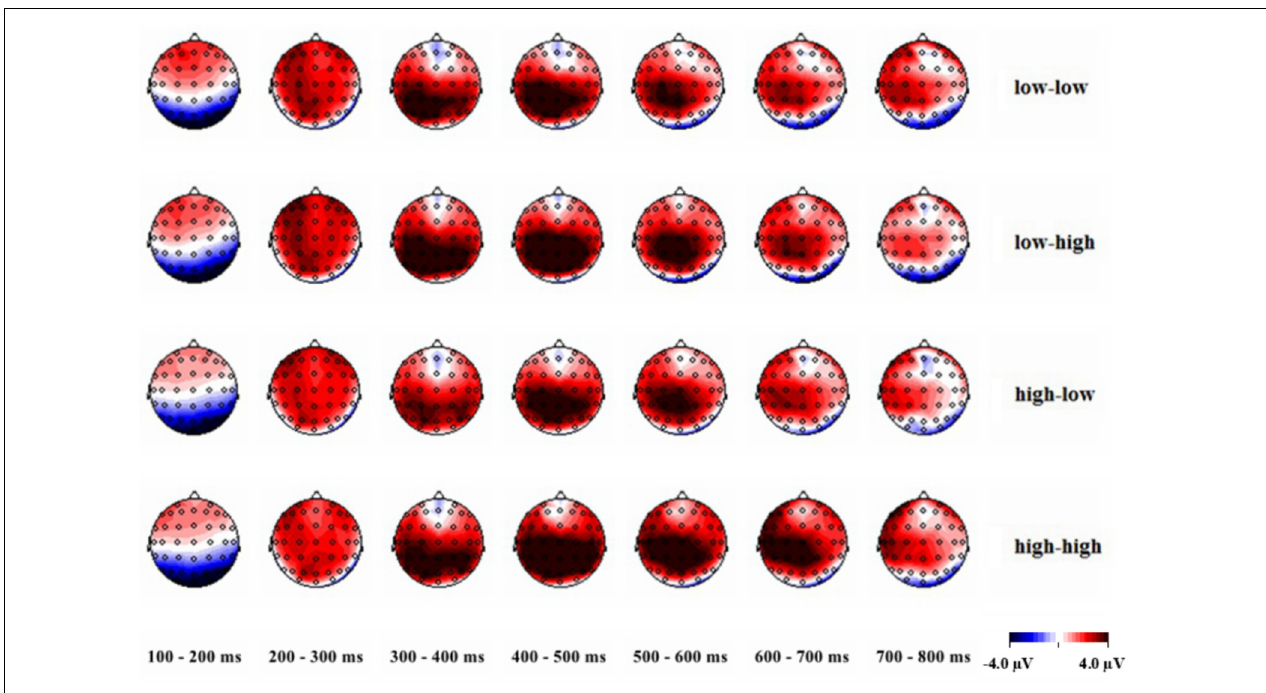
FIGURE 4 | Comparison of the voltage topographic maps for the four different